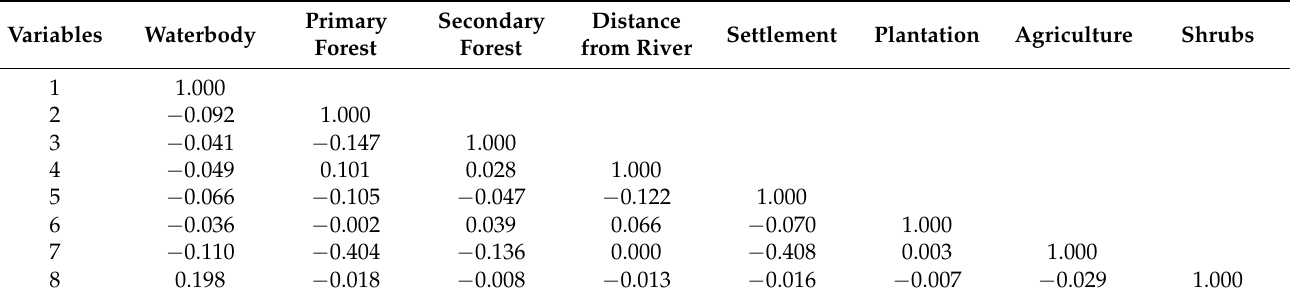
Table 3. Results of multicollinearity analysis in 2000.